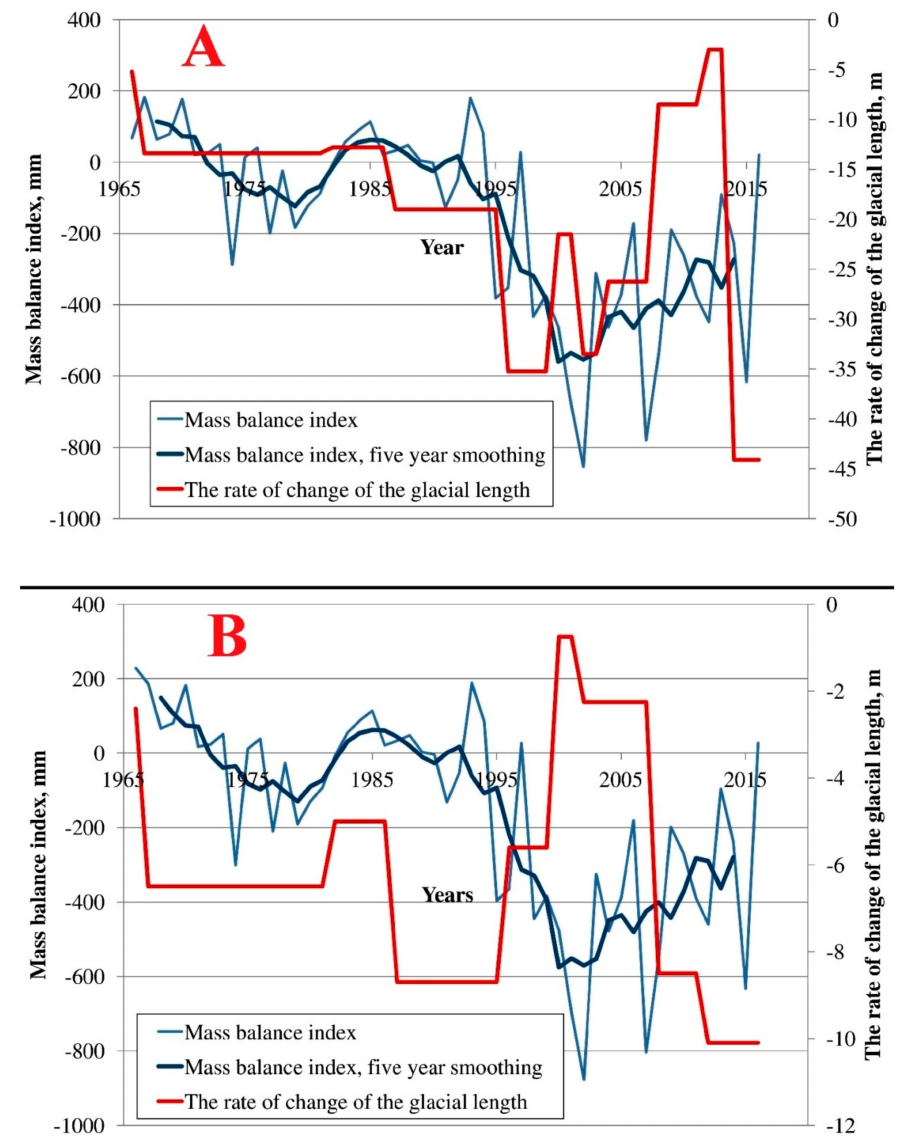
Figure 15. Mass balance index (mm w.e.) curves of the Seliverstova Glacier ( A ) and the East Mugur Glacier ( B ) for the firn line altitudes (3450 m and 3350 m, respectively); smoothed (over 5-year intervals) mass balance index curves mm w.e.; the average rate of changes in the length of the glaciers, m · year − 1